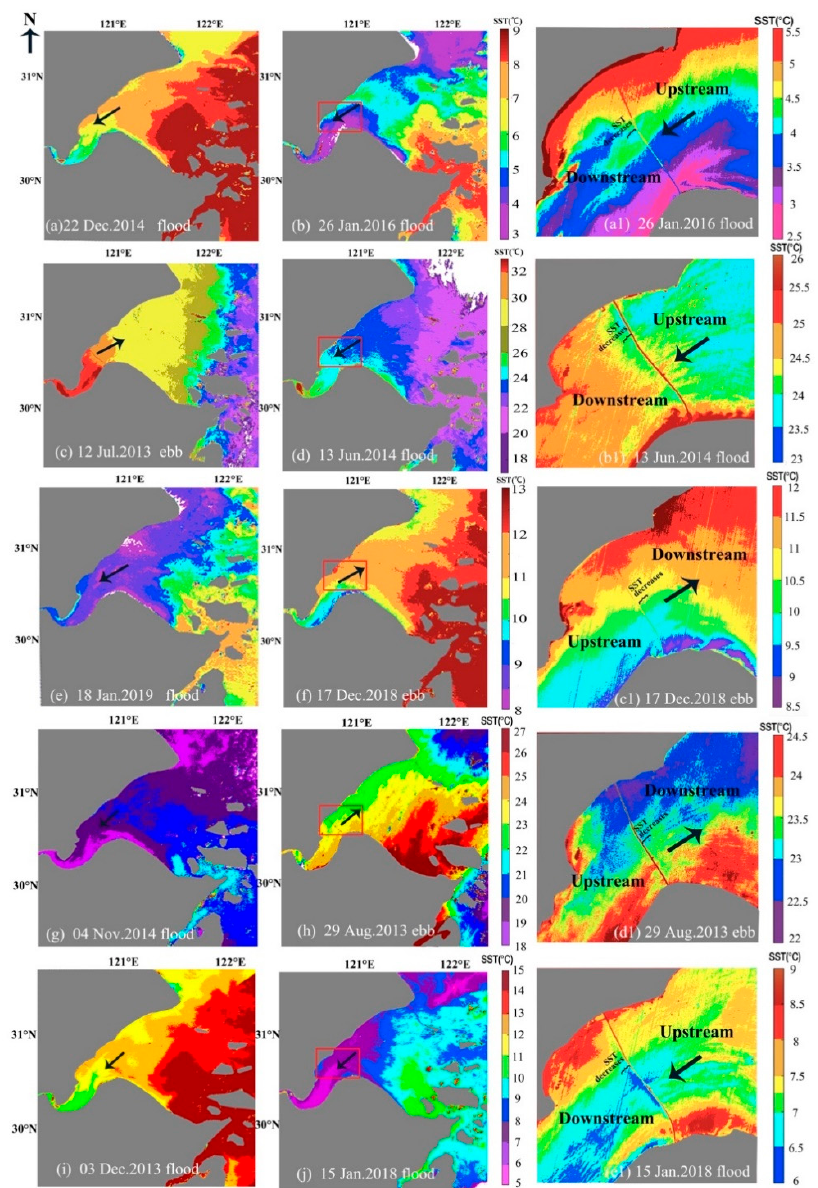
Figure 4. Sea surface temperatures retrieved from Landsat 8 images on 22 December 2014 ( a ), 26 January 2016 ( b ), 12 July 2013 ( c ), 13 June 2014 ( d ), 18 January 2019 ( e ), 17 December 2018 ( f ), 4 November 2014 ( g ), 29 August 2013 ( h ), 3 December 2013 ( i ) and 15 January 2018 ( j ). ( a , b , d , e , g , i , j ) flood; ( c , f , h ) ebb. ( a1 , b1 , c1 , d1 , e1 ) Sea surface temperature (SST) distribution near the Hangzhou Bay bridge. The red box shows the waters near the Hangzhou Bay